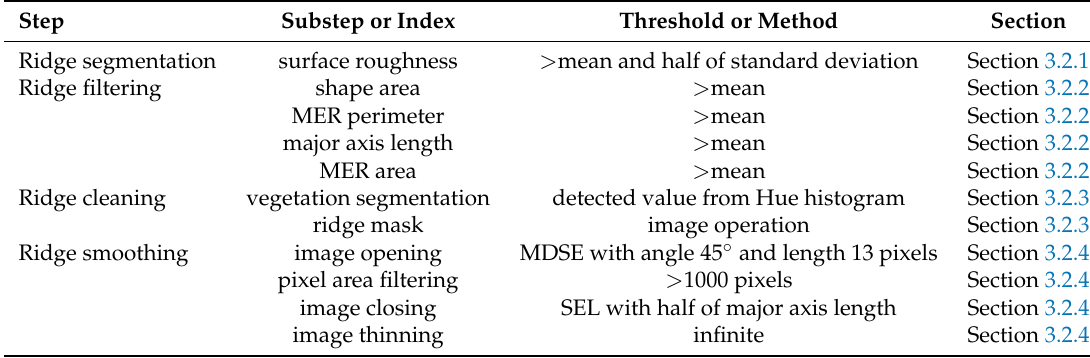
Table 5. Parameter summary of cropland ridge